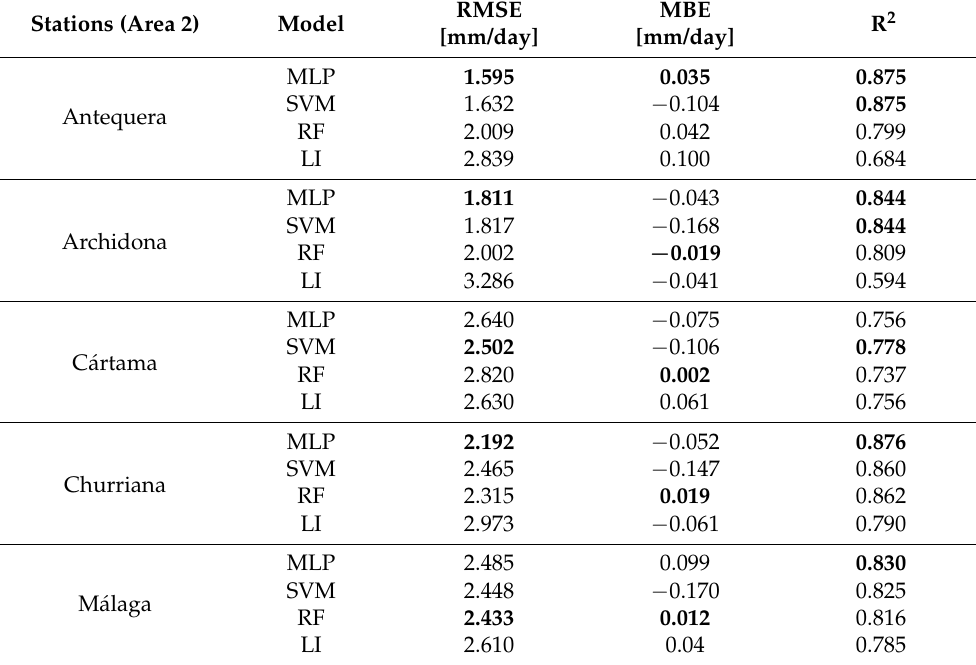
Table 5. RMSE, MBE, and R 2 performance values from testing dataset for all locations and models in the second area (coastal locations), using data from neighbor stations. The best values for each site are in